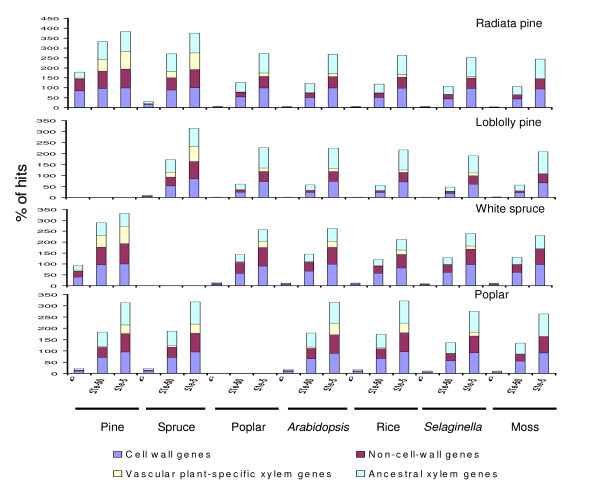
Cell wall genes and ancestral xylem genes are relatively more conserved in diverse plants. Putative cell wall, non-cell-wall, vascular plant-specific xylem (VSX) and ancestral xylem genes within xylem unigenes of radiata pine, loblolly pine, white spruce and poplar were blasted with gene indices (tblastx) of pine and spruce, and gene models (blastx) of poplar, Arabidopsis, rice, Selaginella and moss. Percentage of hits is presented on the Y-axis at three E-value cut-offs (0, 1e-50 and 1e-5). Different numbers of hits observed with cell wall and non-cell-wall genes, as well as with VSX and ancestral xylem genes were statistically tested assuming a binomial distribution. All comparisons showed statistical significances (P < 0.001) (data not show for the simplicity of the figure) except for a few between conifers at 1e-5.